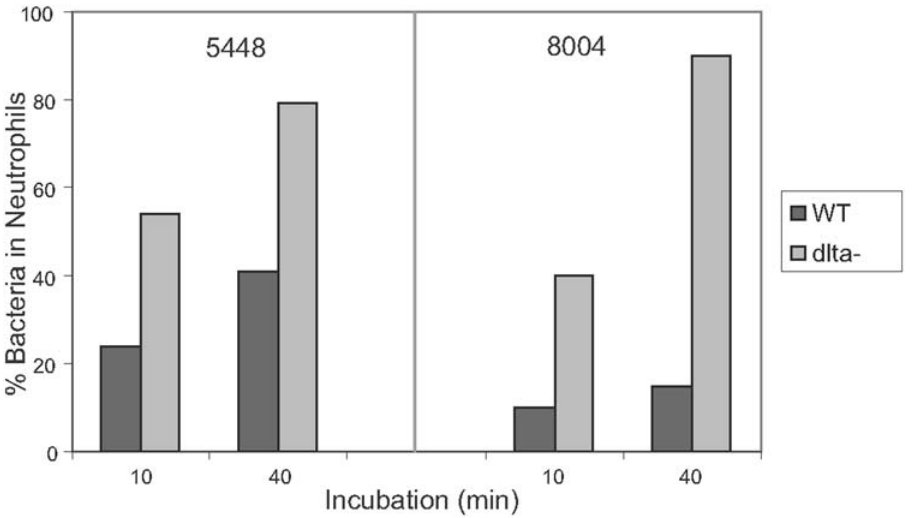
Figure 3. Opsonophagocytosis test. WT and D dltA mutant bacteria were grown to mid-log phase, washed and incubated in whole human blood for 10 or 40 minutes. Blood samples were placed on slides and stained. The percent of bacteria associated with neutrophils was determined by light microscope analysis.